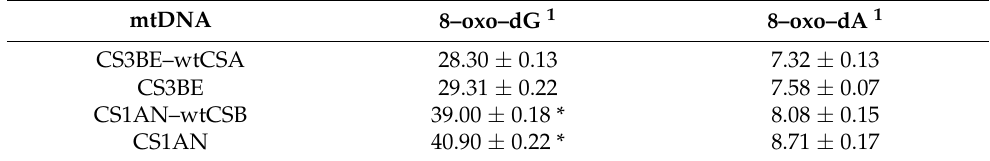
Table 1. The levels (lesions/10 7 nucleosides) of 8–oxo–dG and 8–oxo–dA in mtDNA isolated from CSA and CSB (wt and defective) cells.